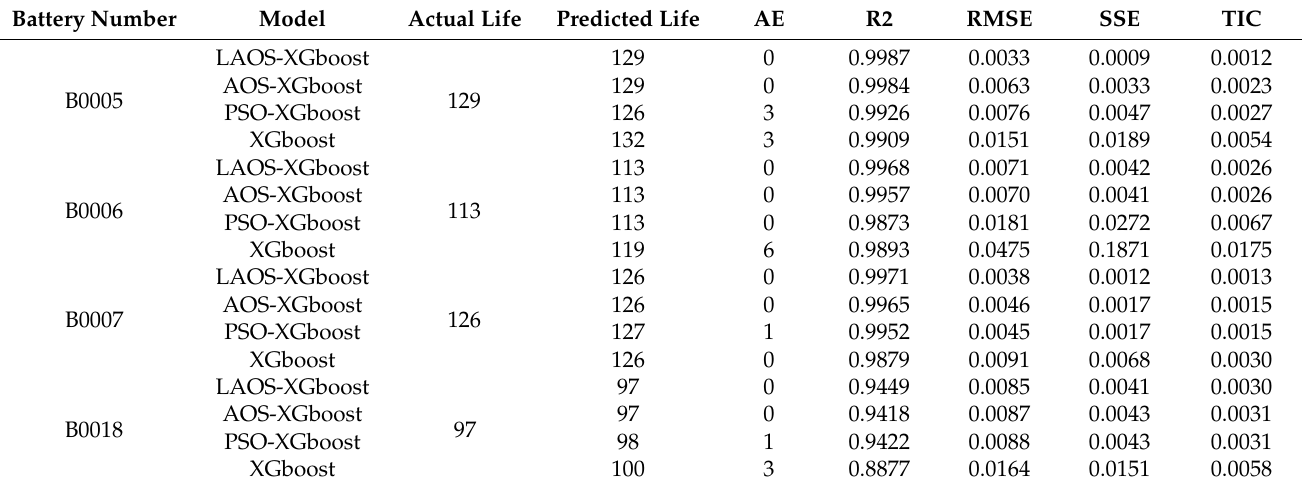
Table 4. Evaluation results of different models under the same